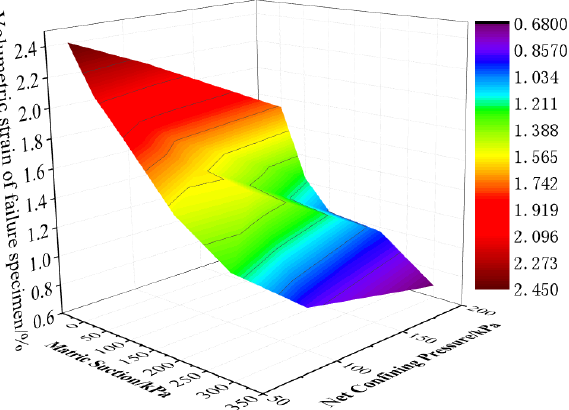
Figure 14. Cloud diagram of volumetric strain with matric suction and net confining pressure.